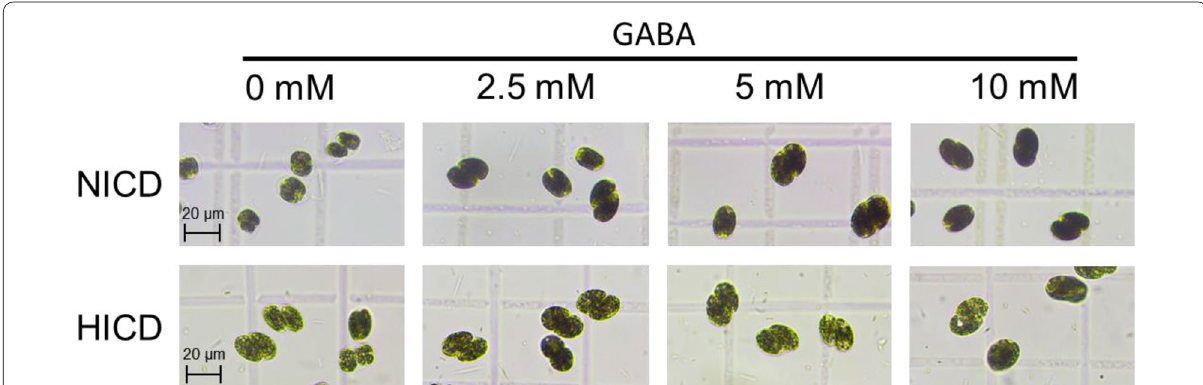
Fig. 6 Starch accumulation as revealed by iodine staining in T. subcordiformis exposed to nitrogen deprivation under NICD and HICD conditions with GABA supply on Day 4. *, **, and *** denote the significant differences at p < 0.1, p < 0.05, and p < 0.01 levels, respectively, under different GABA conditions (2.5–10 mM) compared to those under 0 mM GABA (means